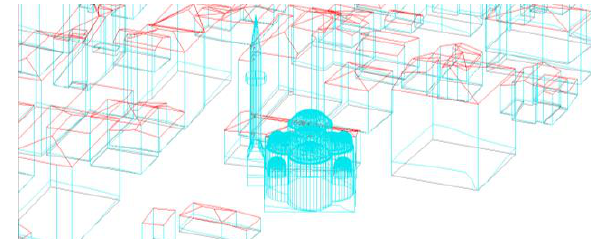
Figure 7. Example of LoD2 buildings and LoD2+ building (mosque)